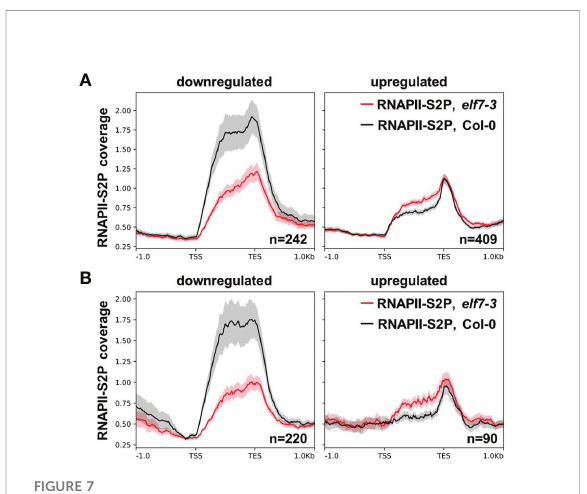
FIGURE 7 RNAPII coverage over genes up- and downregulated in elf7-3 . Metagene plots of ChIP-seq analysis of Col-0 and elf7-3 using an antibody directed against RNAPII-S2P over DEGs elf7-3/Col-0 under standard condtions (A) or upon exposure to NaCl (B) . Mean signals of the three biological replicates were averaged (line) and the shaded area represents the SEM for the three replicates at each position. The tracks were scaled over transcribed regions from transcriptional start site (TSS) to transcriptional end site (TES).